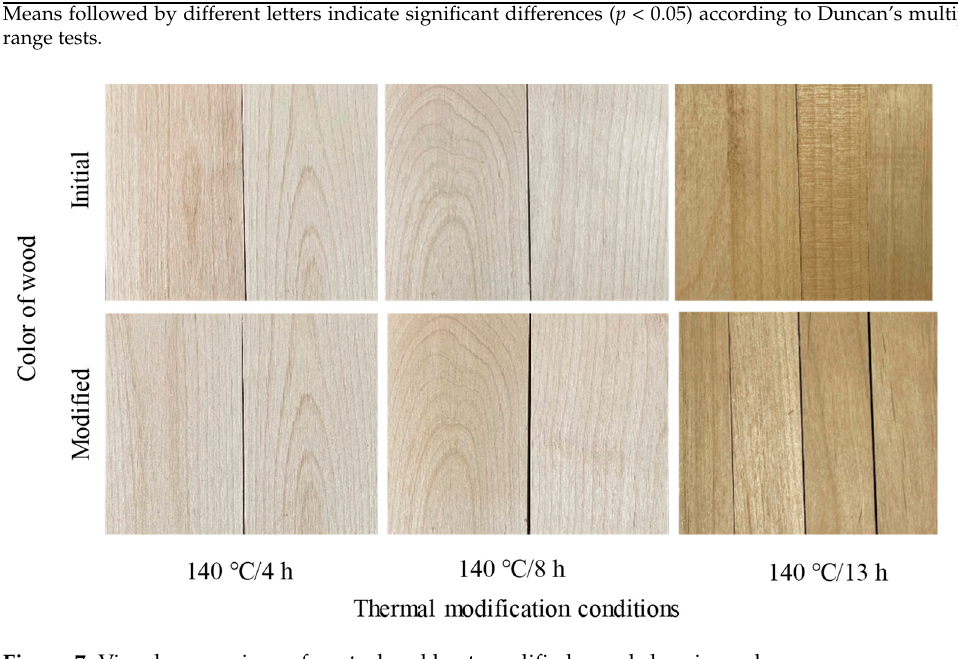
Figure 7. Visual comparison of control and heat-modified wood showing color.